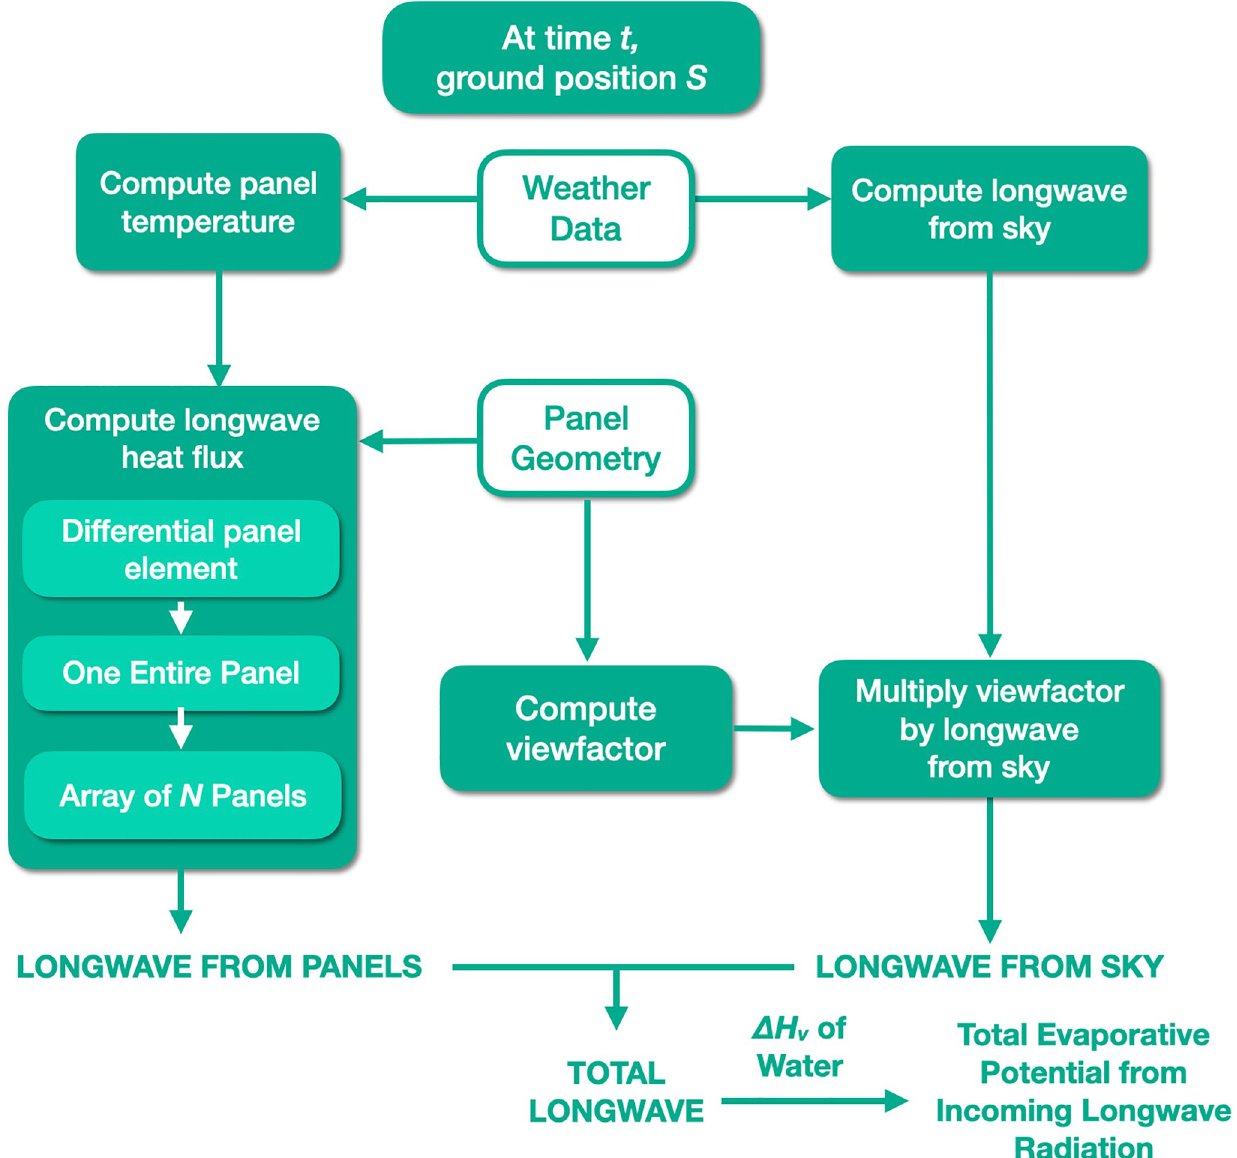
Fig 1. Complete process for modeling evaporation potential from longwave